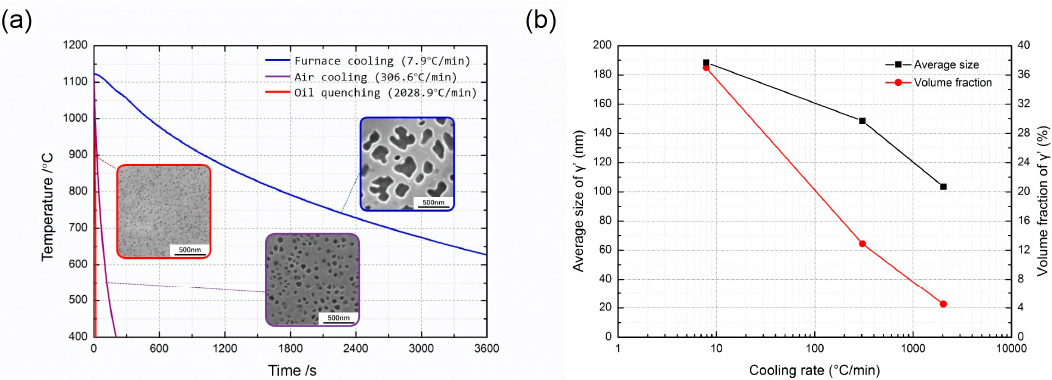
Figure 2. ( a ) Cooling curves of the three different cooling modes. The insets in the frame show typical γ ’ precipitates after heat treatment; ( b ) Relationship between cooling rate and average size as well as volume fraction of γ ’ precipitates. Notice that the horizontal axis is logarithmic.